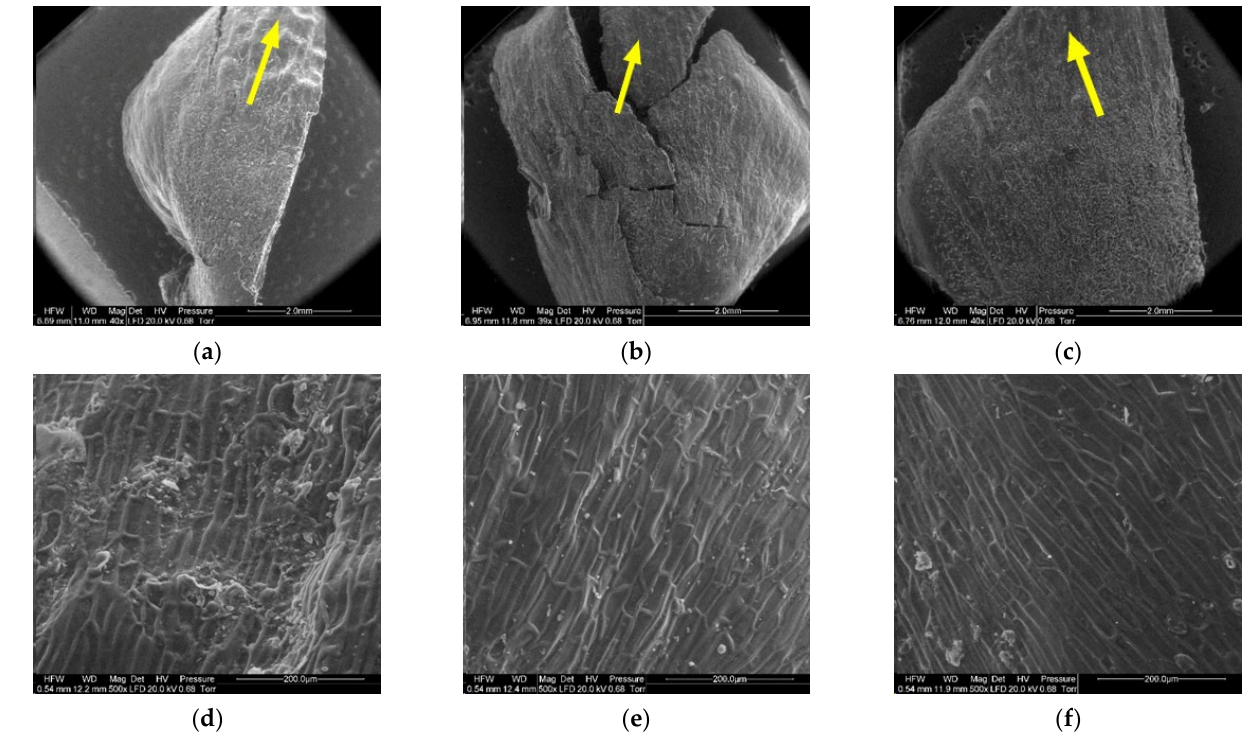
Figure 11. Outer side of larch scale. Distal scale area: ( a ) MC = 20%, zoom 50×; ( b ) MC = 10%, zoom 50×; ( c ) MC = 5%, zoom 50×; ( d ) MC = 20%, zoom 500×; ( e ) MC = 10%, zoom 500×; and ( f ) MC = 5%, zoom 500×.